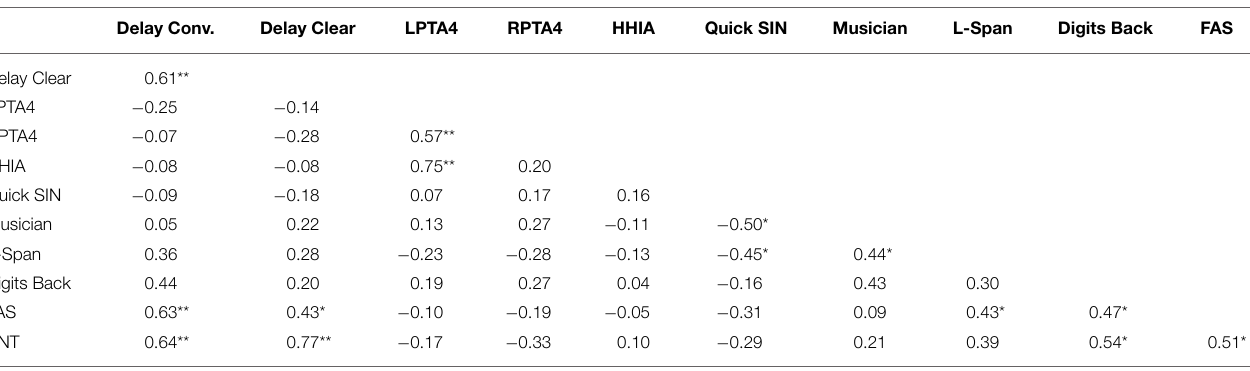
TABLE 9 | Correlation analysis between delayed memory performance in the conversational (conv.) and clear listening conditions and hearing and cognitive abilities–Quiet group. Delay Conv.